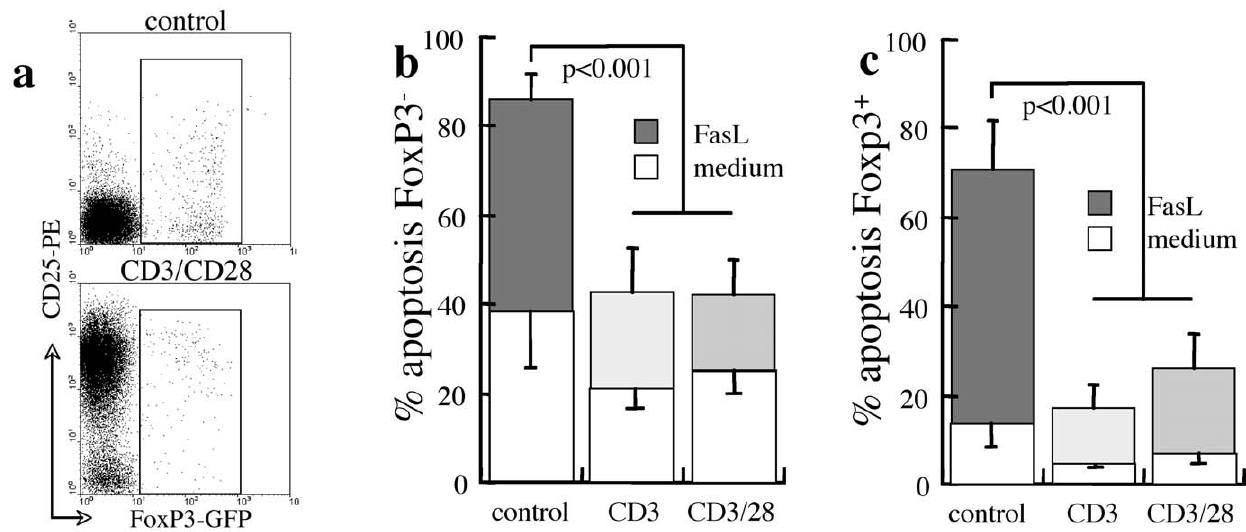
Figure 5. Sensitivity to apoptosis under stimulation in reference to FoxP3 expression. A. CD4 + T cells do not upregulated FoxP3 expression under CD3/CD28 stimulation in mixed splenocyte cultures from FoxP3-GFP transgenes. Apoptosis was determined in control medium and with FasL under CD3 and CD3/CD28 stimulation in (B) gated FoxP3 2 T cells (n=5) and (C) gated FoxP3 + T cells (n=6) in mixed cultures of splenocytes from transgenic FoxP3-GFP mice.